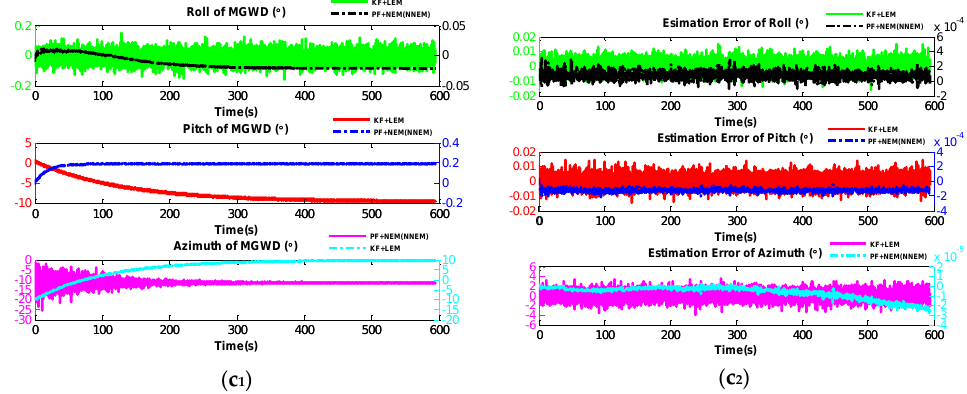
Figure 9. Comparison of the performance of KF with LEM and PF with NEM or NNEM under small-angle attitude errors conditions. ( a 1 ) and ( a 2 ) are the estimated attitude and the corresponding estimation error; ( b 1 ) and ( b 2 ) are the estimated velocity and the corresponding estimation error; ( c 1 ) and ( c 2 ) are the estimated position and the corresponding estimation error. Plotting the figure uses the double Y-axis plotting approach because the results are in different orders of magnitude.